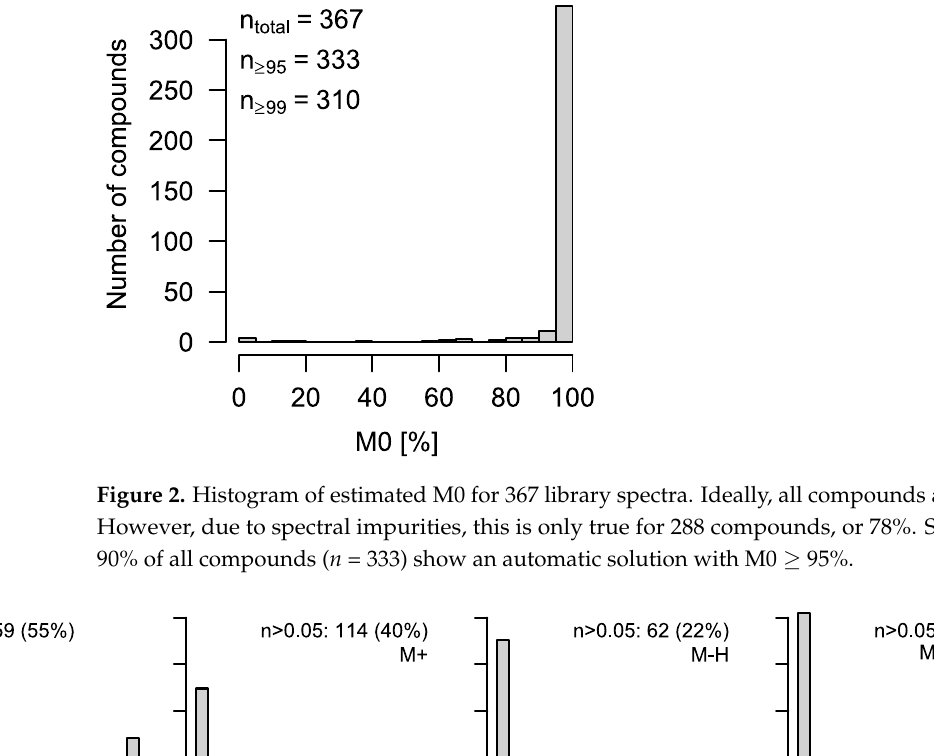
Figure 2. Histogram of estimated M0 for 367 library spectra. Ideally, all compounds are M0 = 100%. However, due to spectral impurities, this is only true for 288 compounds, or 78%. Still, more than 90% of all compounds ( n = 333) show an automatic solution with M0 ≥ 95%.